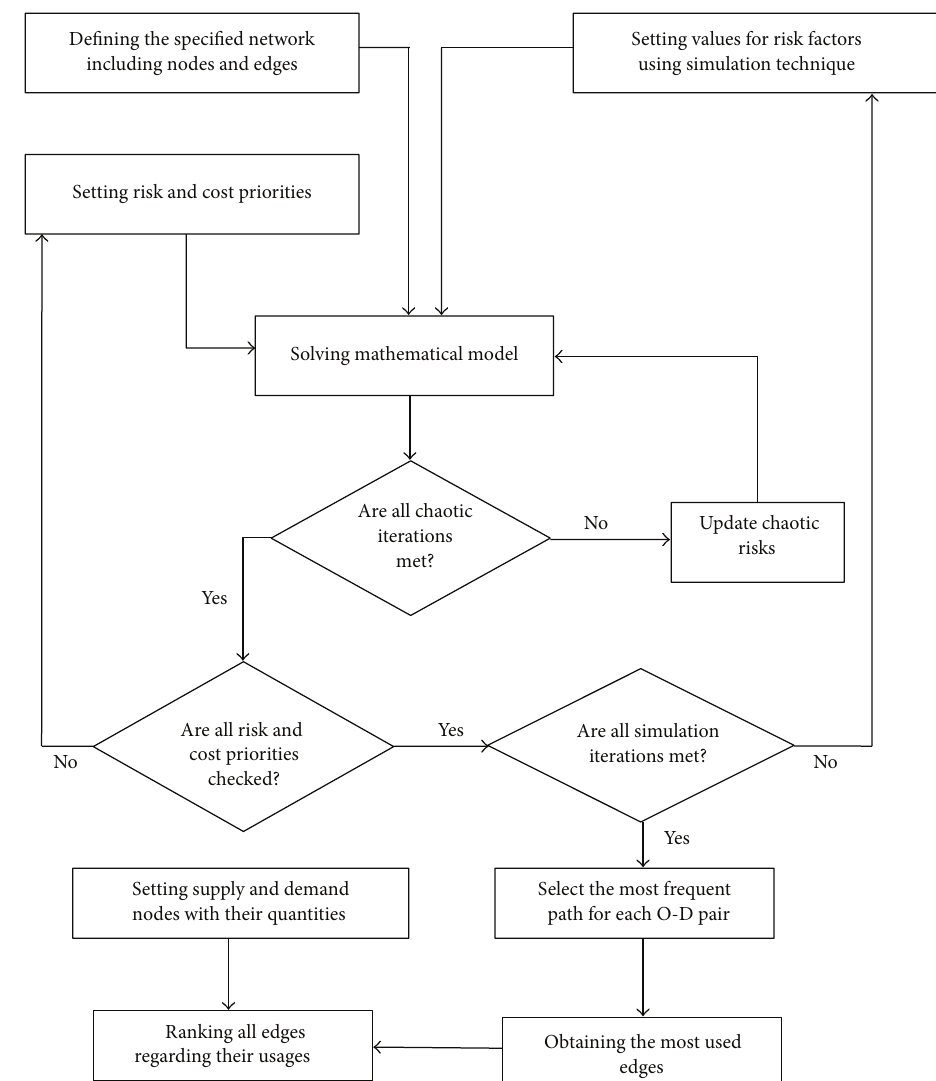
Figure 1: An overall view of the proposed